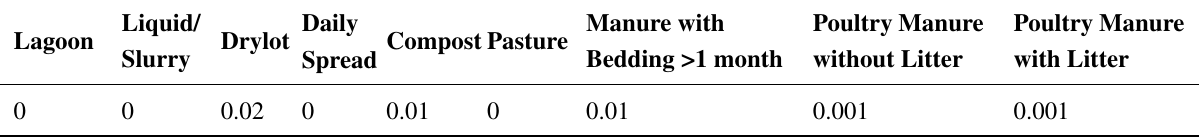
Table 7. IPCC 2006 default N O emissions factors for different manure management 2